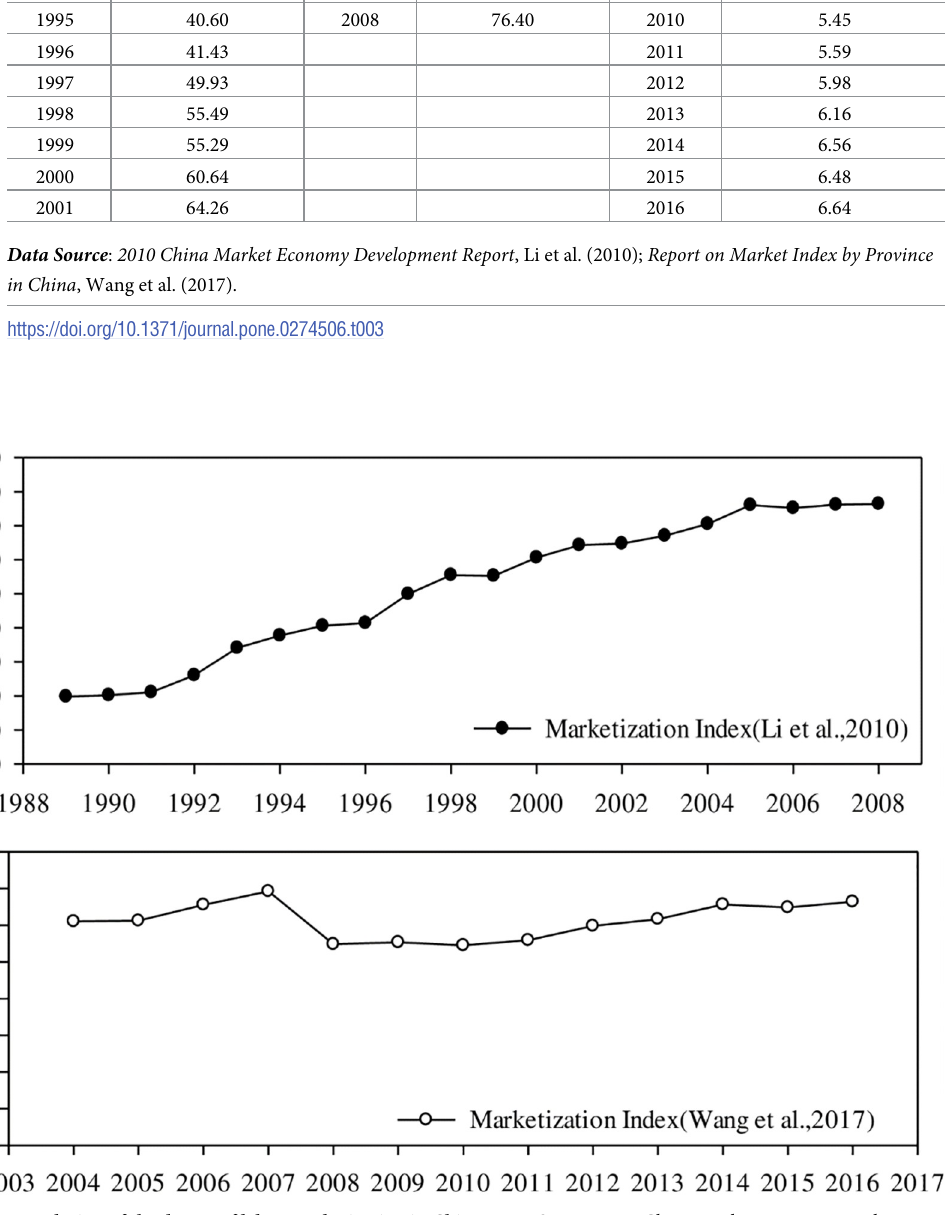
Fig 5. Evolution of the degree of labor marketization in China. Data Source : 2010 China Market Economy Development Report , Li et al. (2010); Report on Market Index by Province in China , Wang et al.